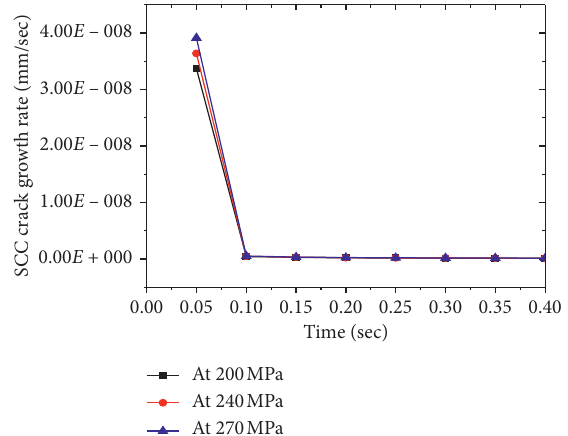
Figure 11: SCC crack growth rate (mm/sec) vs. time.